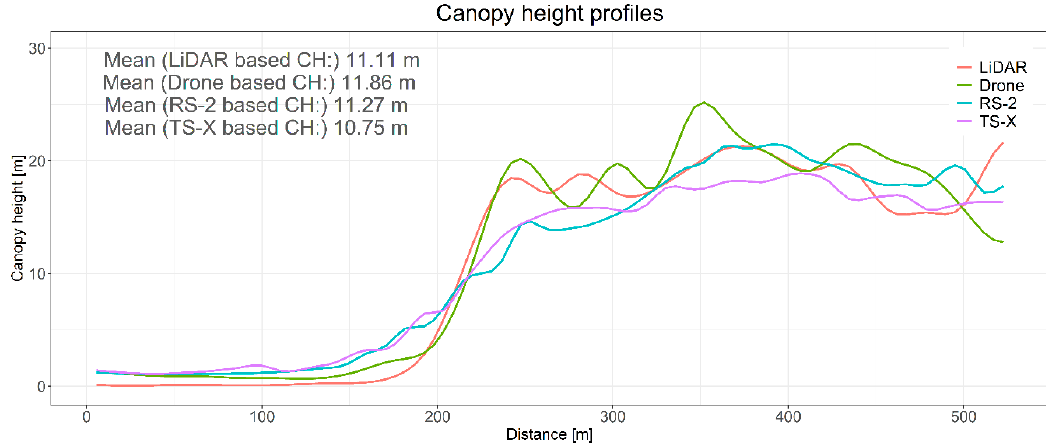
Figure 4. Example height profile of reference LiDAR canopy height, drone canopy height, modelled RS-2 canopy height based on the interferogram from 03.09.-27.09 and modelled canopy height based on TS-X from 06.09.-17.09.